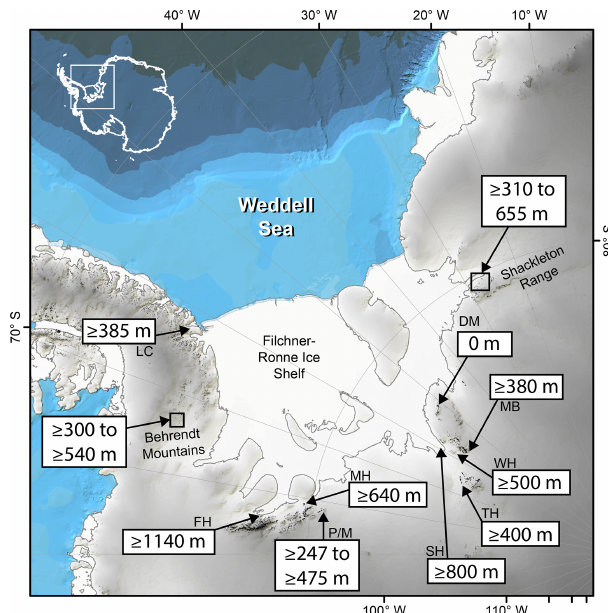
Figure 9. Terrestrial ice thickness constraints inferred from mea- surements of cosmogenic nuclides around the WSE. Constraints for the Lassiter Coast (LC), Shackleton Range, and the Schmidt Hills are sourced from this study. All other ice thickness values and loca- tions are the same as in Fig.